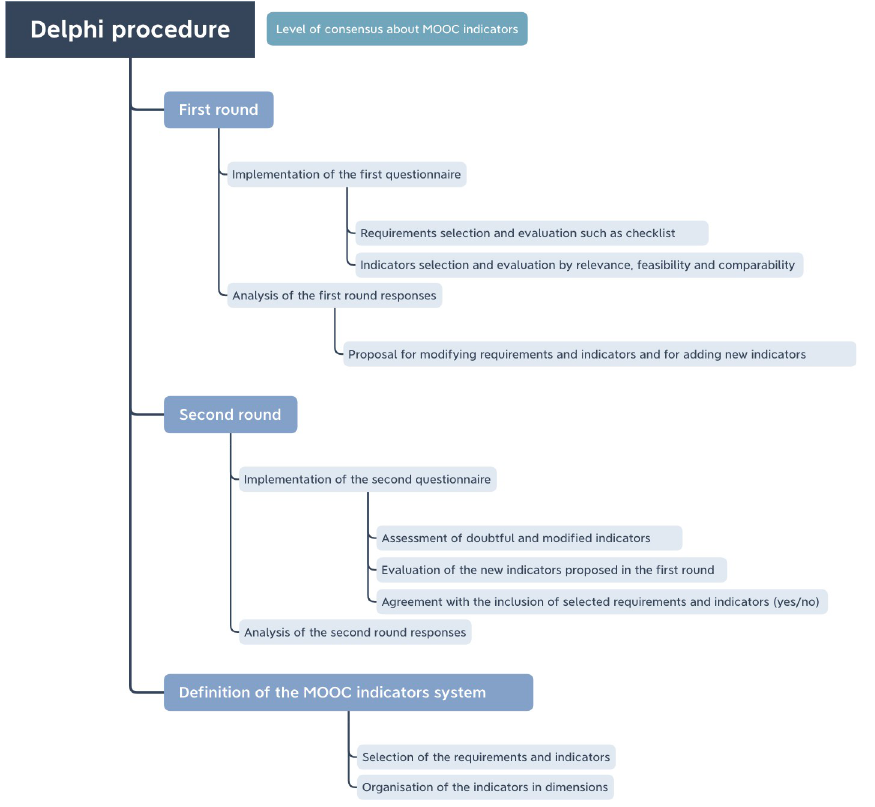
Fig 1. Delphi procedure. Note. Own